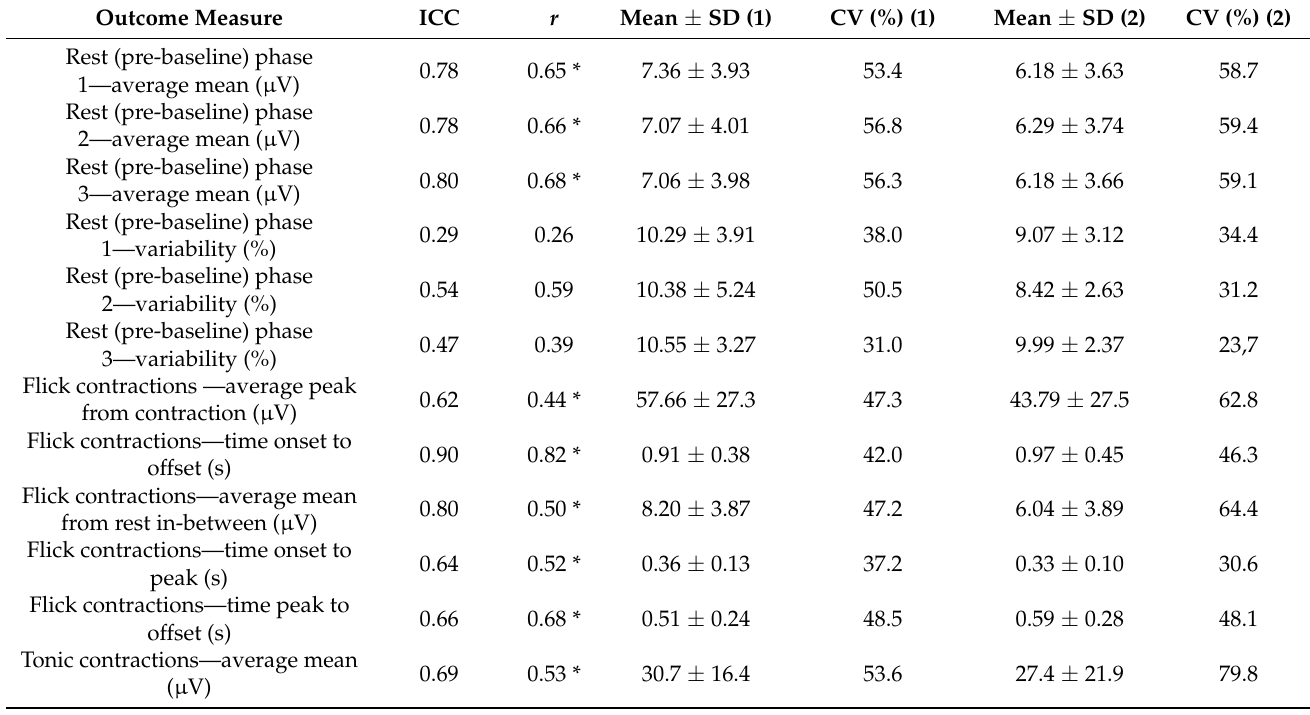
Table 4. Our multi-activity sEMG protocol between-day